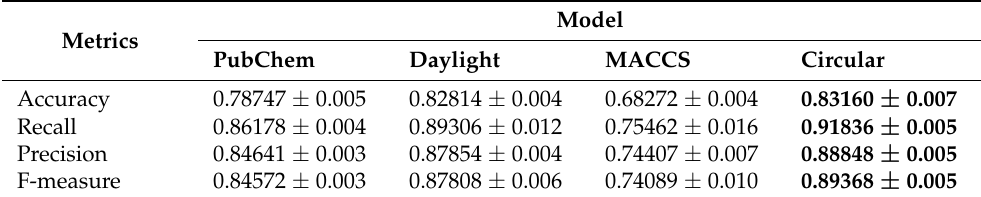
Table 3. SAE-DNN comparison results for all the feature extraction datasets.